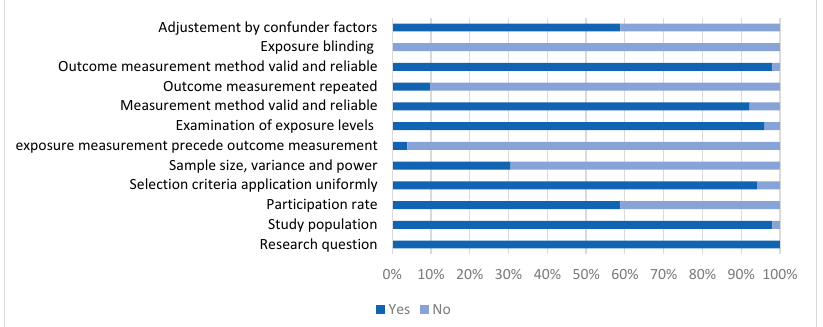
Figure 2. Completion of cross-sectional studies using NHLBI quality assessment tool. Table 1. Newcastle–Ottawa Scale assessment of the cohort studies analyzing factors associated to fruits and vegetables